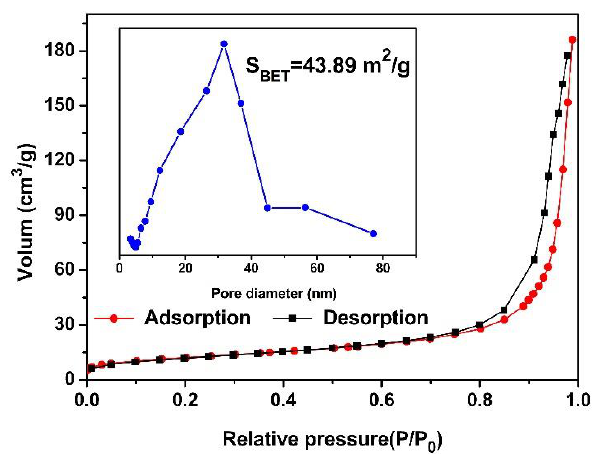
Figure 5. Nitrogen adsorption–desorption isotherm along with the pore size distribution of the NiFe 2 O 4 nano-octahedrons.